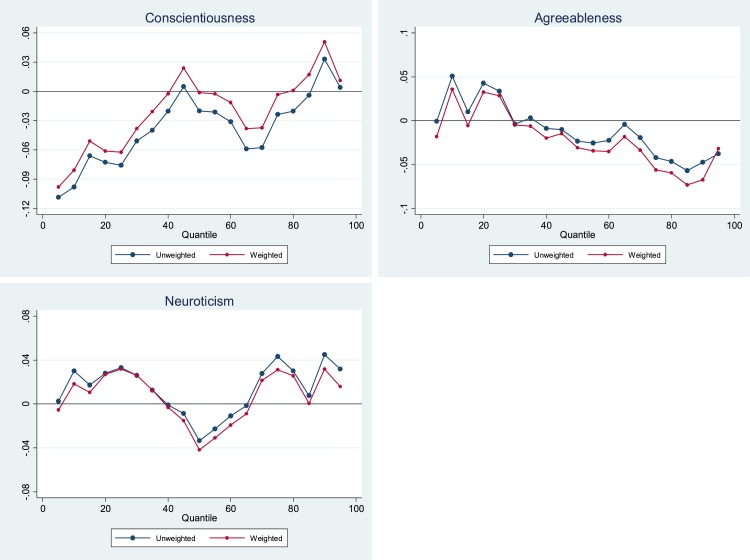
Weighted non-cognitive skills – C-reactive protein relationship.